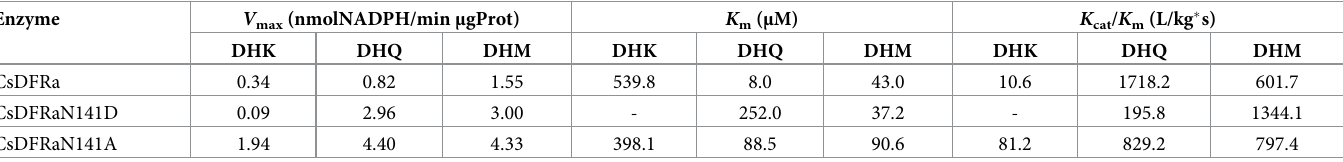
Table 2. Kinetics of CsDFRa and its two mutants for three DHF substrates.